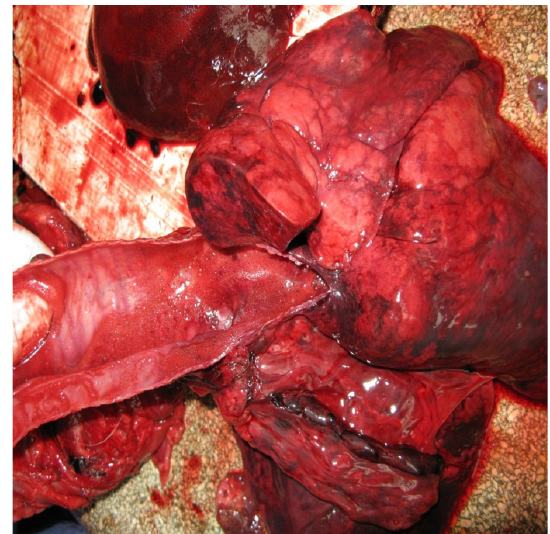
Fig. 10. The lungs are heterogeneously colored: red, some- times with pink and dark cherry areas